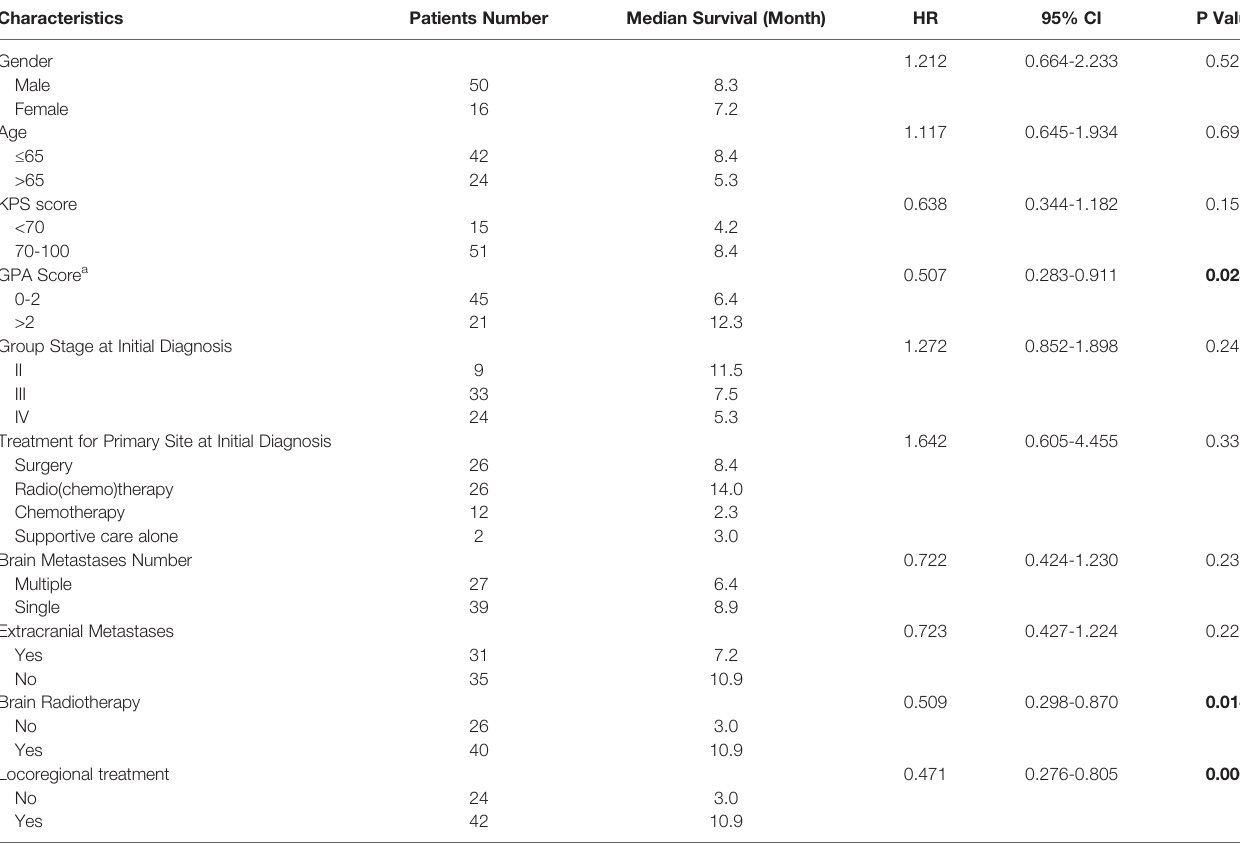
TABLE 3 | Univariate analysis of various potential prognostic factors for survival in patients.